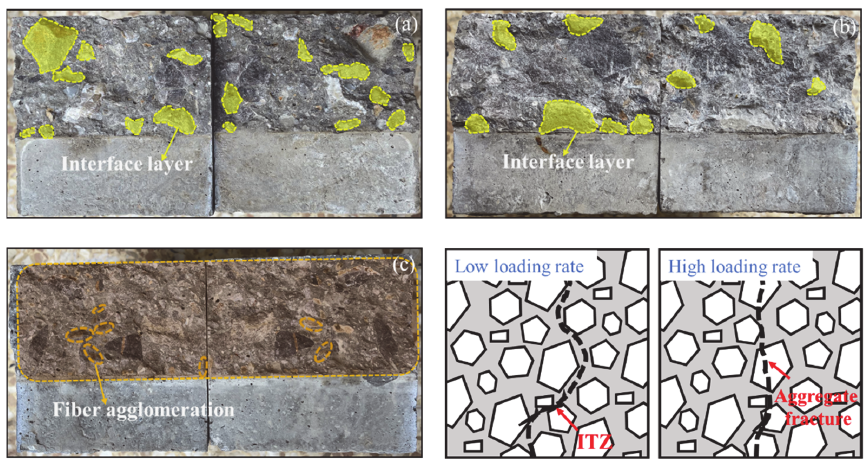
Figure 4. The failure sections of concrete at different loading rates: ( a ) 10 − 6 s − 1 ; ( b ) 10 − 4 s − 1 ; and ( c ) 10 − 2 s − 1 .